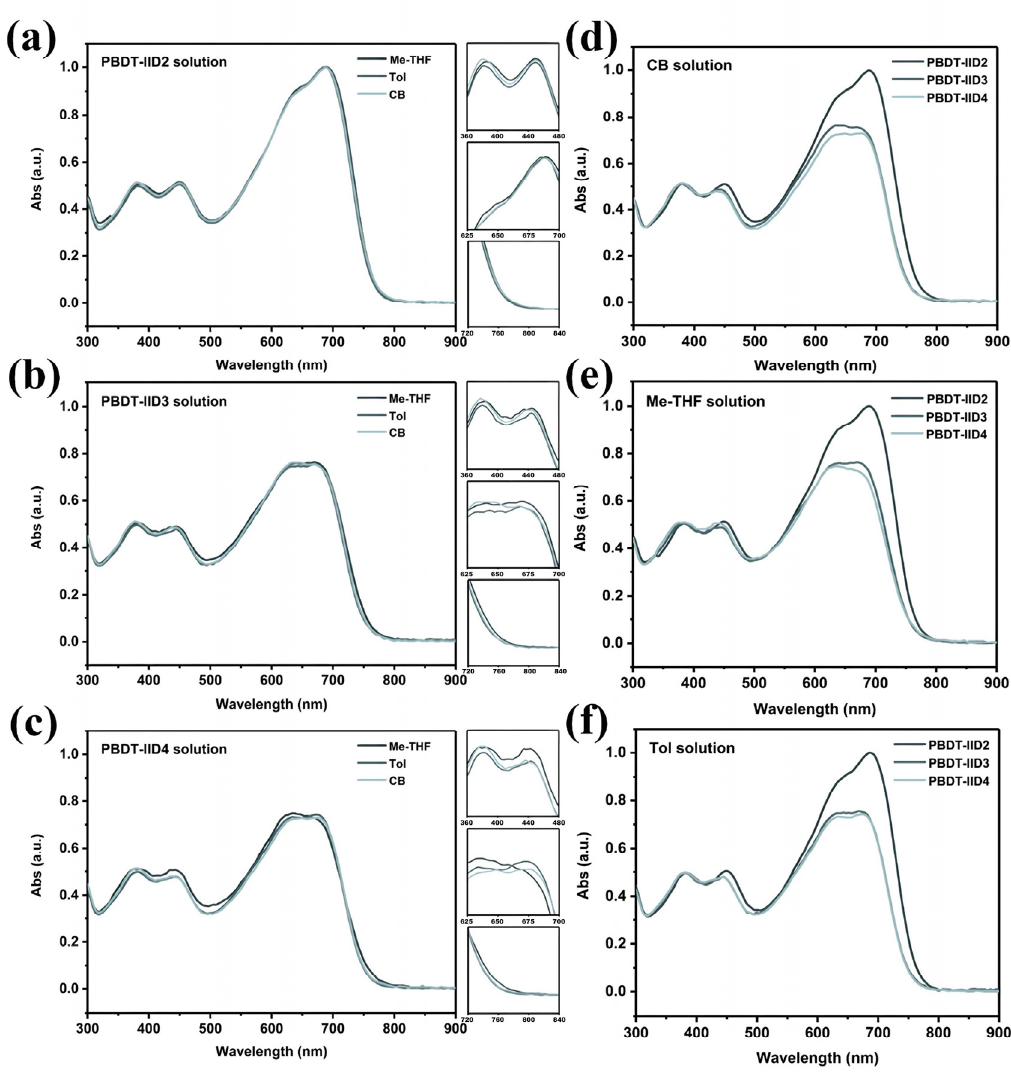
Figure 4. ( a ) UV-vis absorption spectra of PBDT-IID2 in Me-THF, toluene and CB at 25 ◦ C, respectively; ( b ) UV-vis absorption spectra of PBDT-IID3 in Me-THF, toluene and CB at 25 ◦ C, respectively; ( c ) UV-vis absorption spectra of PBDT-IID4 in Me-THF, toluene and CB at 25 ◦ C, respectively; ( d ) UV-vis absorption spectra of PBDT-IID2, PBDT-IID3, and PBDT-IID4 in CB solution at 25 ◦ C, respectively; ( e ) UV-vis absorption spectra of PBDT-IID2, PBDT-IID3, and PBDT-IID4 in Me-THF solution at 25 ◦ C, respectively; ( f ) UV-vis absorption spectra of PBDT-IID2, PBDT-IID3, and PBDT-IID4 in toluene solution at 25 °C, respectively. Table 2. The optical properties of the PBDT-IID solutions (in THF) and thin films.